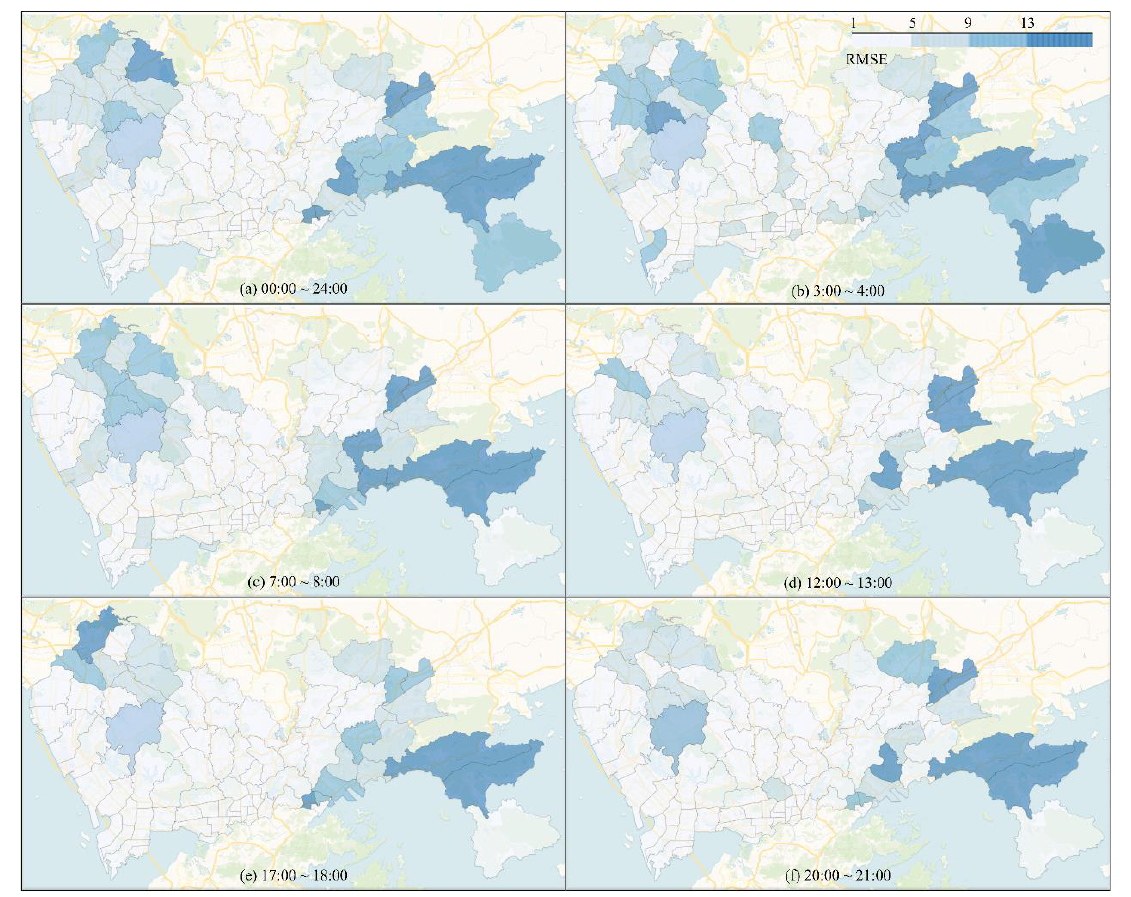
Figure 8. Comparison of the RMSE values of all 78 regions for various time periods.